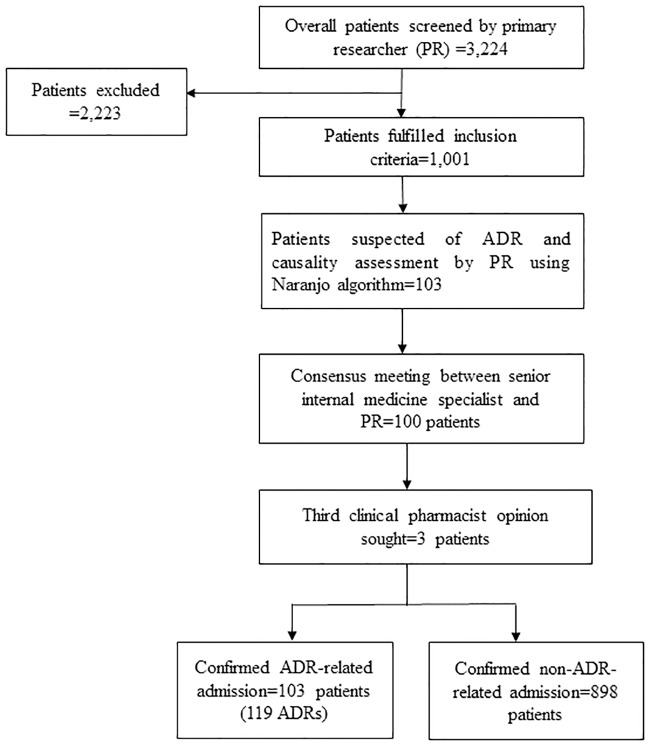
The diagram outlining patient screening and identification of ADR-related admissions.